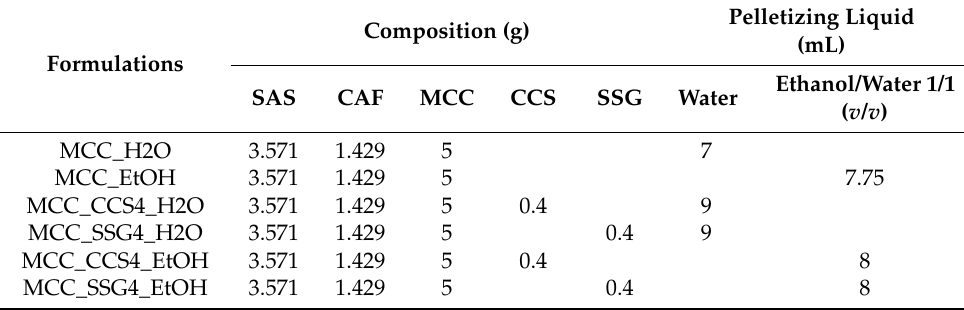
Table 1. Composition of the pellet